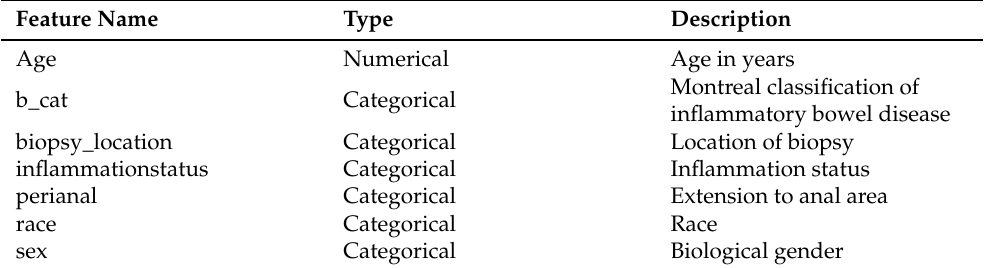
Table A2. List of features included in the inflammatory bowel disease clinical view dataset.